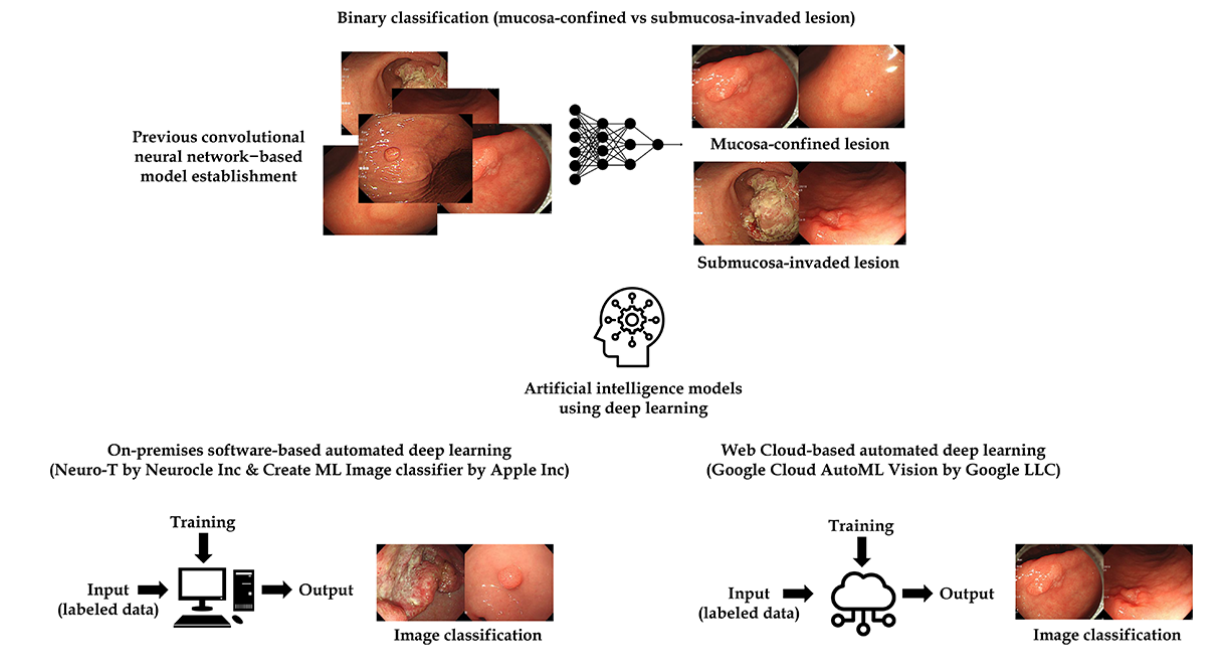
Figure 1. Schematic flow for the establishment of automated deep learning models in data construction.